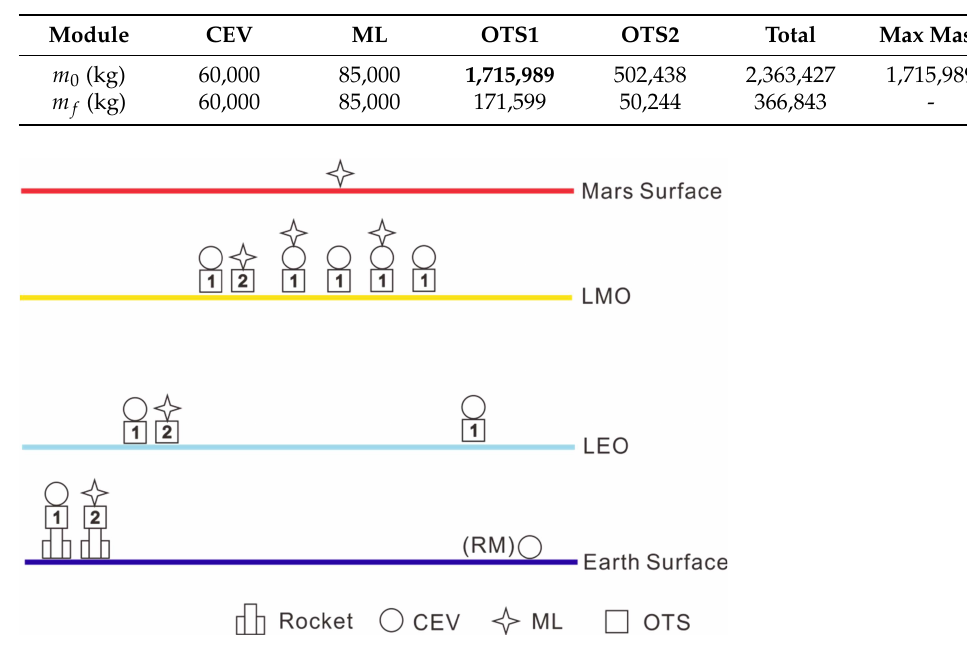
Table 8. Mass scale of Architecture-2.